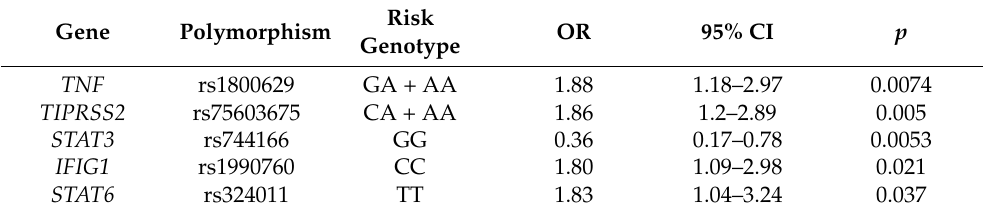
Table 6. Markers associated with the risk of the asymptomatic, mild, or moderate forms becoming severe (subgroup B1 (healthy + asymptomatic + mild + medium) versus subgroup B2